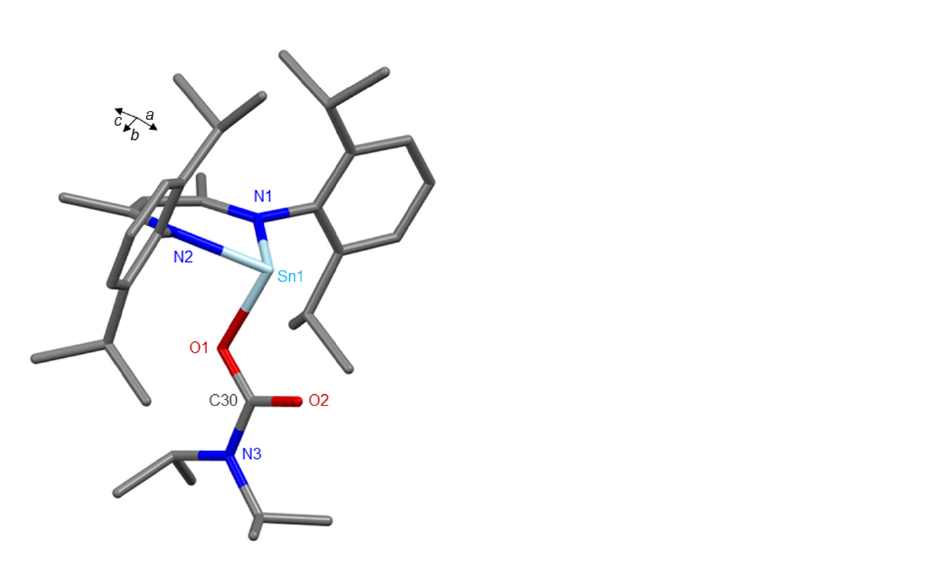
Figure 5. Molecular structure of 6 , adapted from [53] (MERCURY view). Hydrogen atoms are omitted for clarity (Sn light blue, O red, N dark blue, C grey). Table 1. Comparison of selected structural parameters found in carbamates of organotin complexes. Compounds